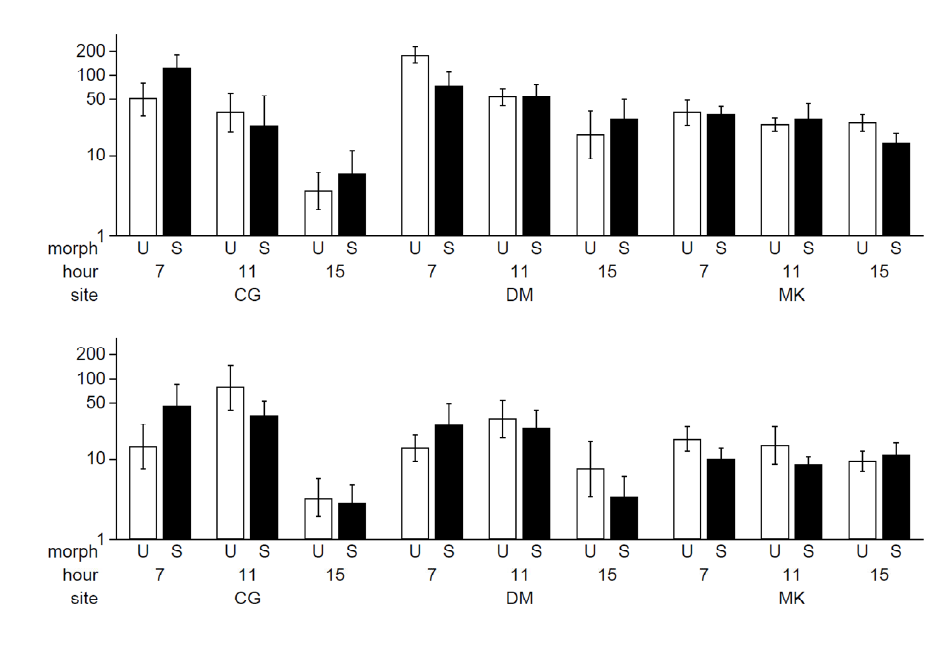
F IG . 4. Per-flower nectar standing crop in C. xantiana ssp . xantiana , measured as weight of sucrose equivalents, for male-phase (top panel) and female-phase (bottom panel) flowers, unspotted (U) and spotted (S) flower color morphs, at three sampling times (0700, 1100, and 1500 hours), at three sites (CG: China Gardens, DM: Democrat, MK: Middle Kern). Bars are means. Error bars represent ± 1 standard